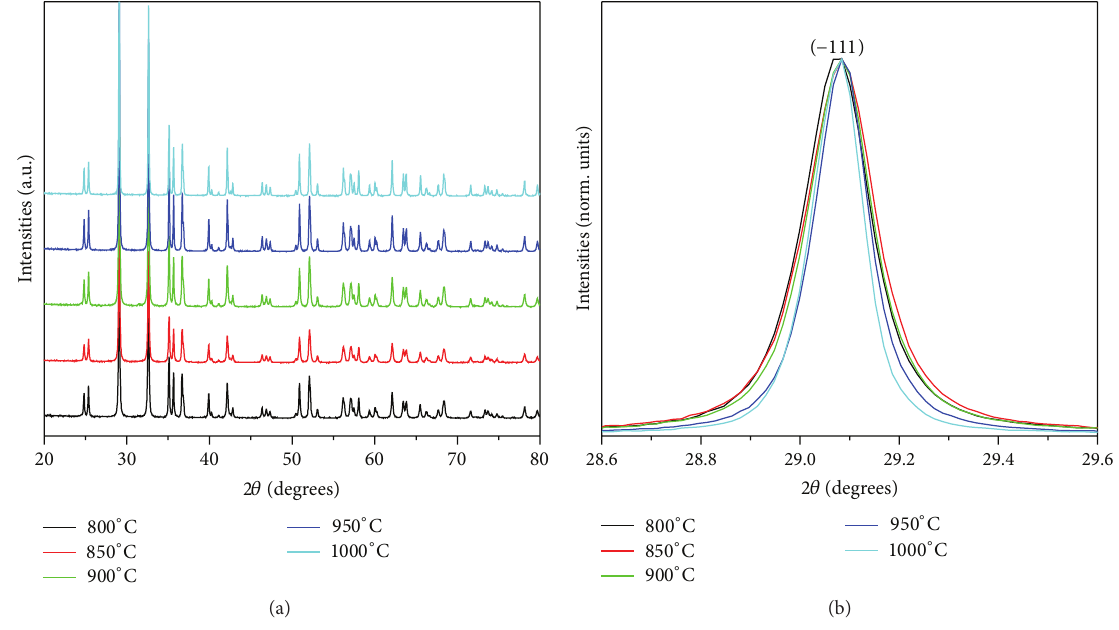
Figure 1: X-ray diffraction patterns of the 𝛽 -TaON powders.